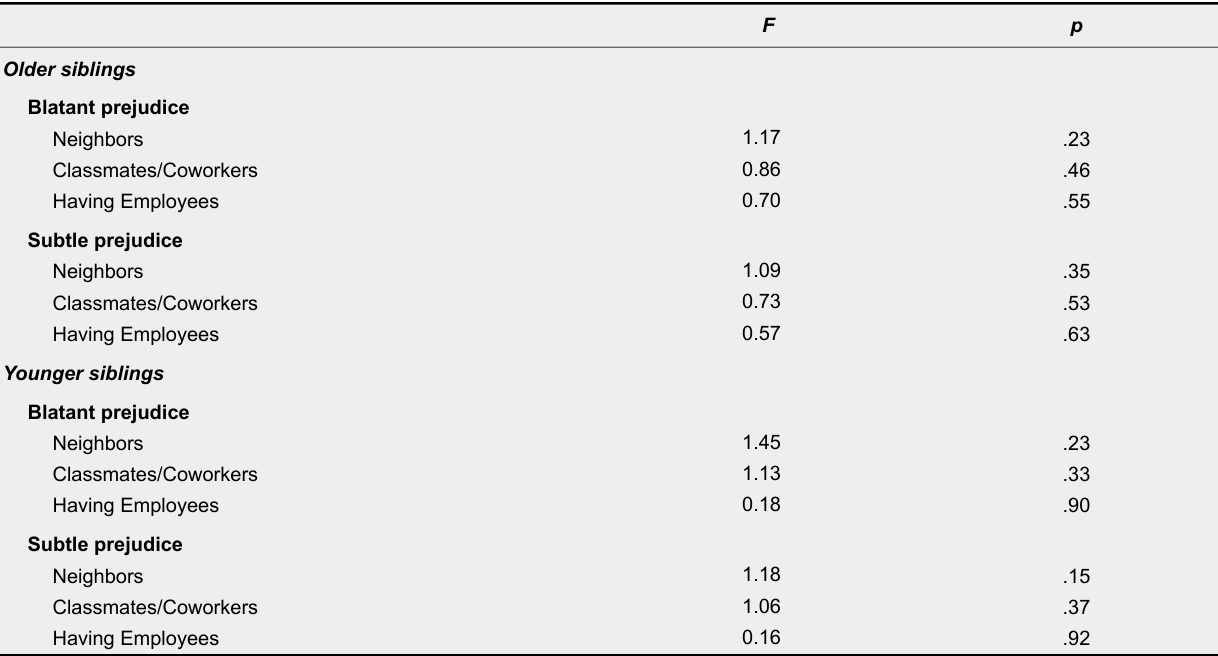
Analyses of Variance for the Contact Typologies